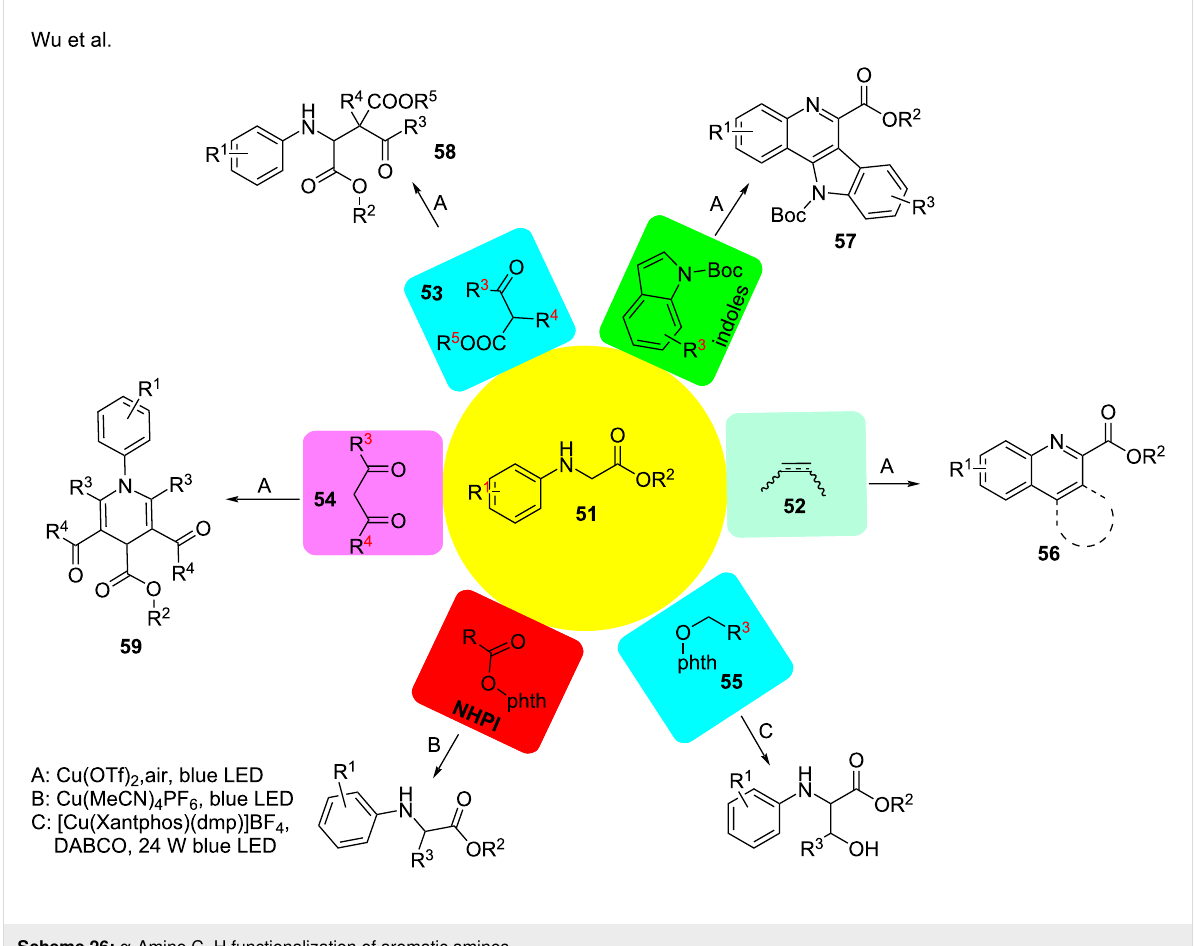
Scheme 26: α -Amino C–H functionalization of aromatic